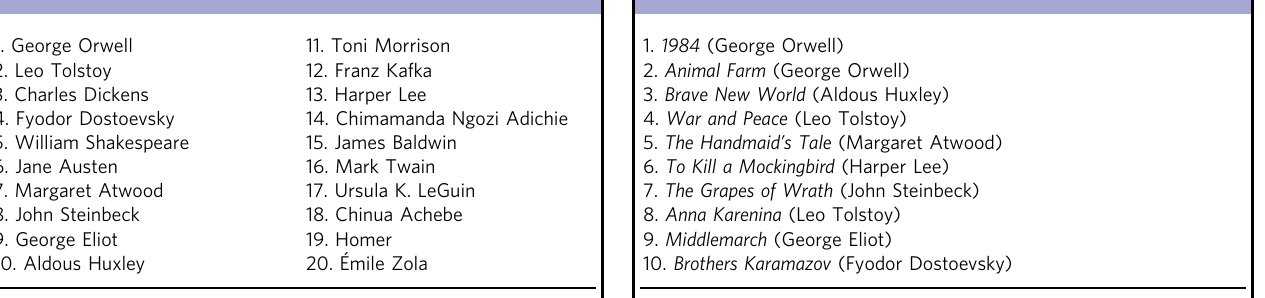
Table 5 Top 20 most referenced authors. Table 6 Top 10 most referenced works of